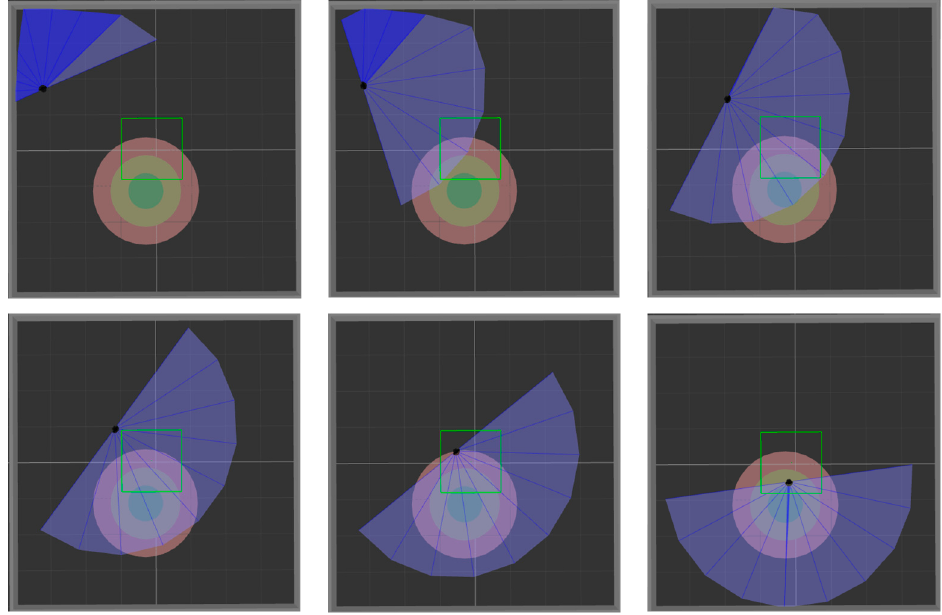
Figure 9. The movement process of mobile robot in simulation Figure 6a.